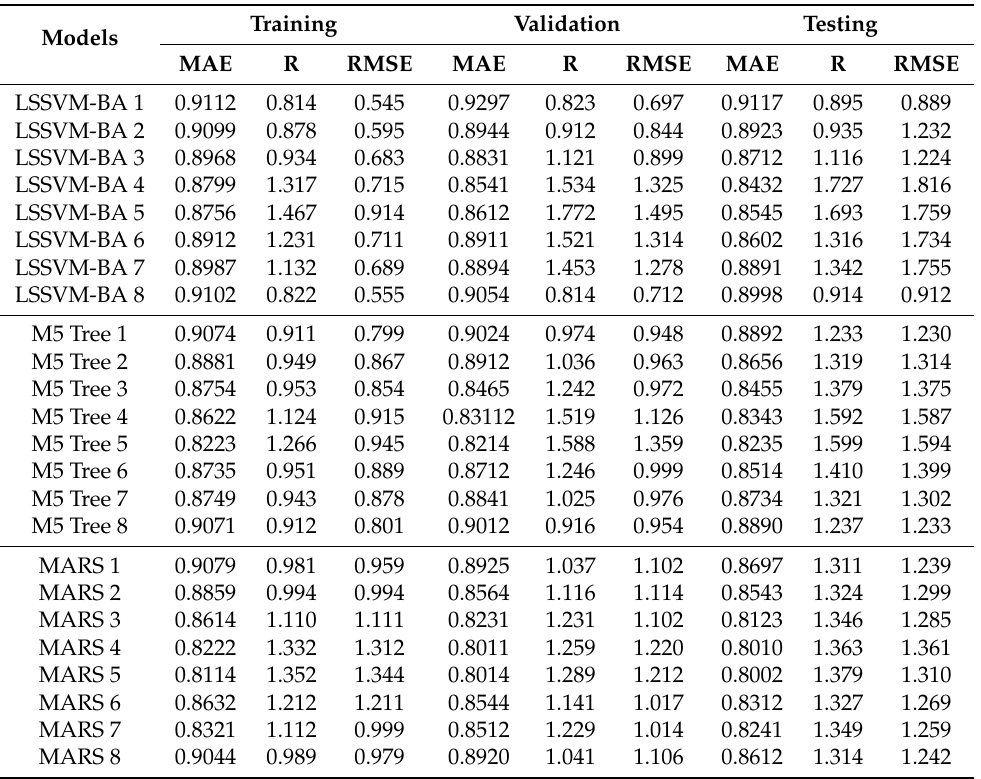
Table 8. The performance of the predictive models during training/validation/testing at USGS 01463500